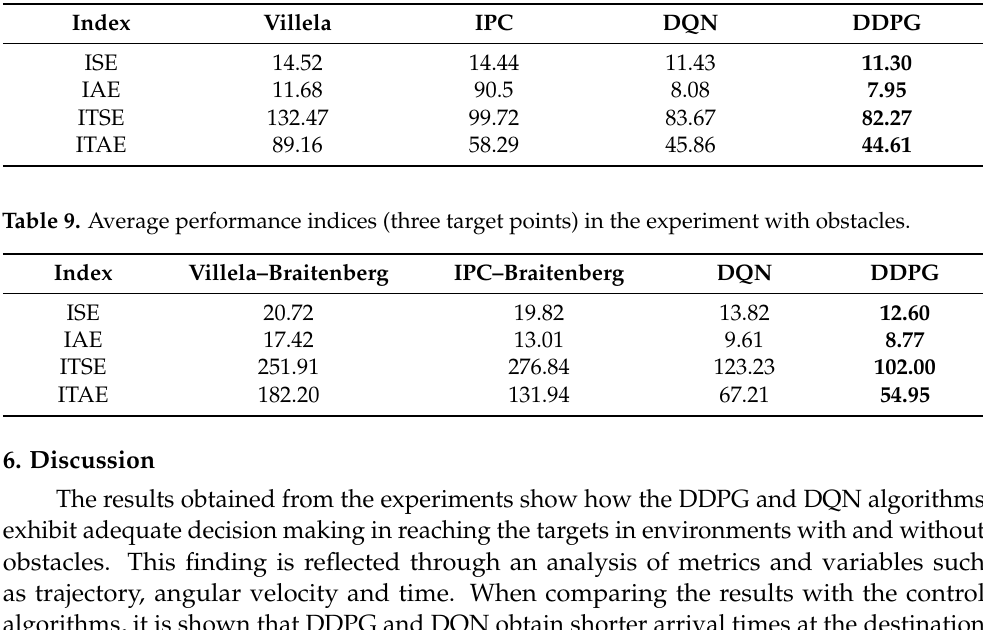
Table 8. Average performance indices (three target points) in the experiment without obstacles.